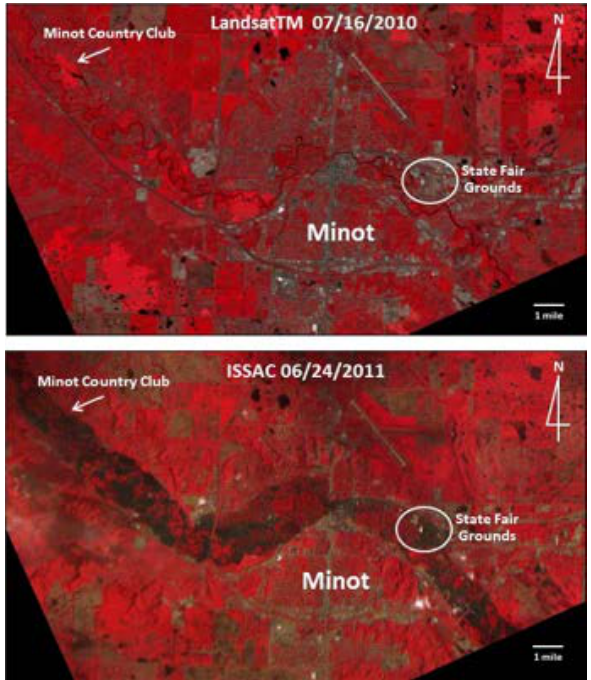
Figure 2. ISSAC data collected on 24 June 2011 indicating flooded regions near Minot, North Dakota (bottom). A pre- flooding Landsat Thematic Mapper image (top) is provided for